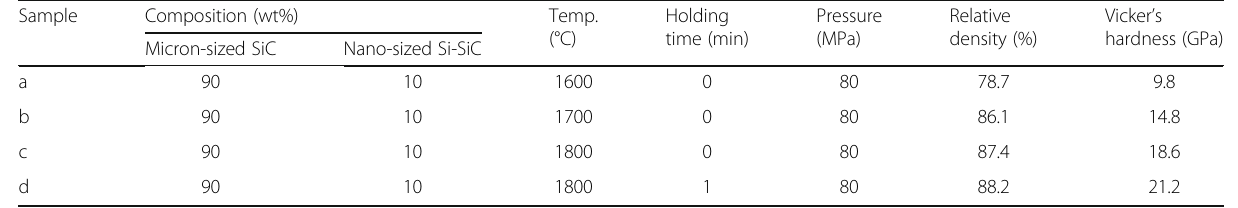
Table 1 Composition of micron-sized SiC and nano-sized Si-SiC composite particle, temperature, and pressure for preparing sintered SiC pellets and their relative densities and Vicker ’ s hardness